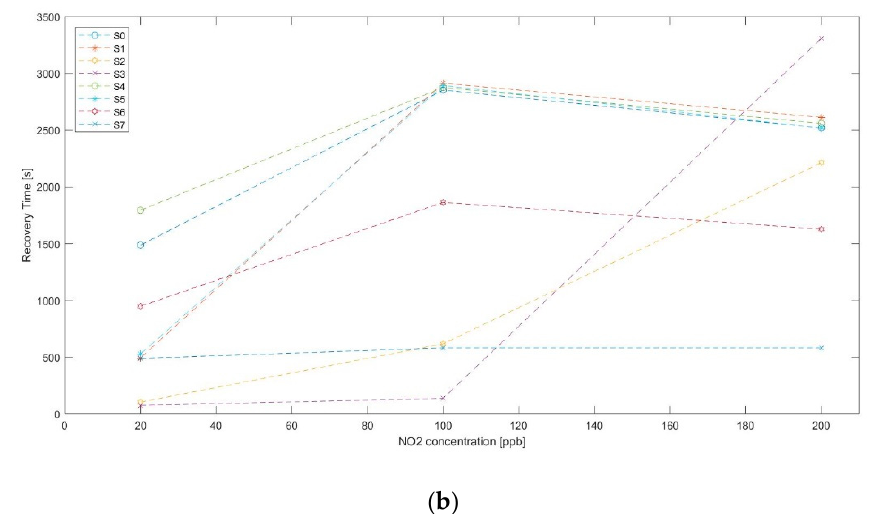
Figure 9: ( a ) The graph shows the recovery of sensor S 0 after exposure to 100 ppb NO 2 while keeping the heater at a constant temperature of 250 °C. The sensor´s recovery time has been calculated as the time until the sensor´s output reaches the 90% of its stable recovered condition. ( b ) Recovery time of sensors S 0 , S 1 , S 2 , S 3 , S 4 , S 5, S 6 and S 7 after exposure to different concentrations of NO 2 .